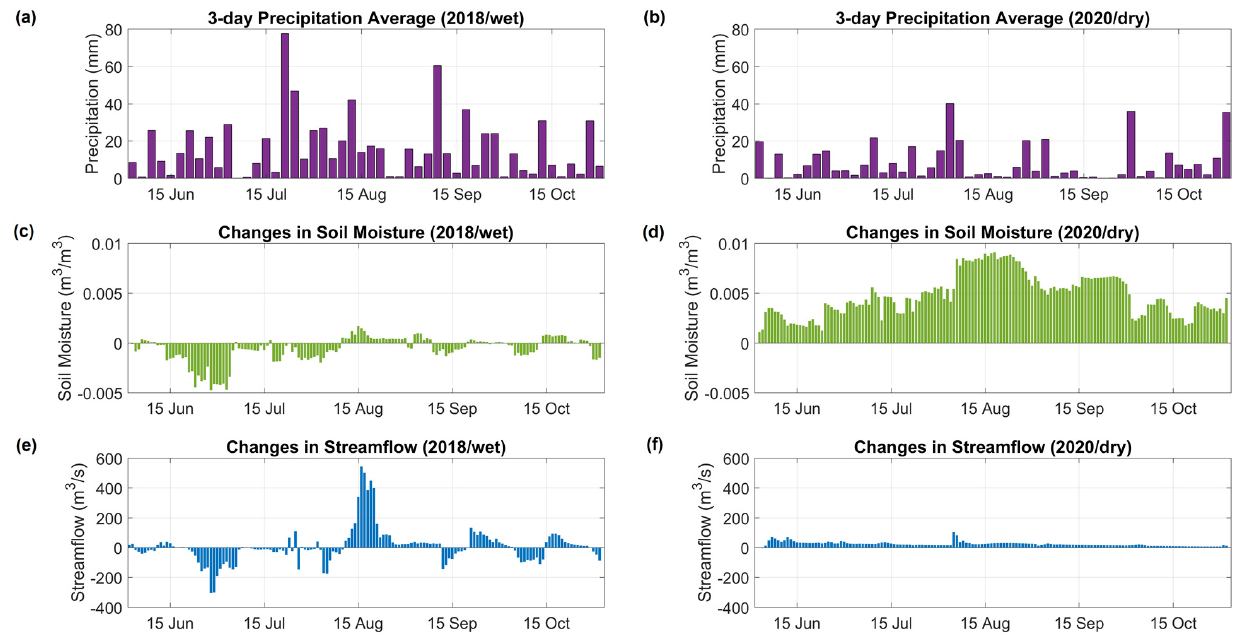
Figure 9. Watershed-averaged 3-day precipitation average ( a , b ), changes in watershed-averaged soil moisture due to data assimilation with Scenario 1 ( c , d ), and changes in streamflow of watershed outlet due to data assimilation ( e , f ) in 2018 ( left column ) and 2020 ( right column ).